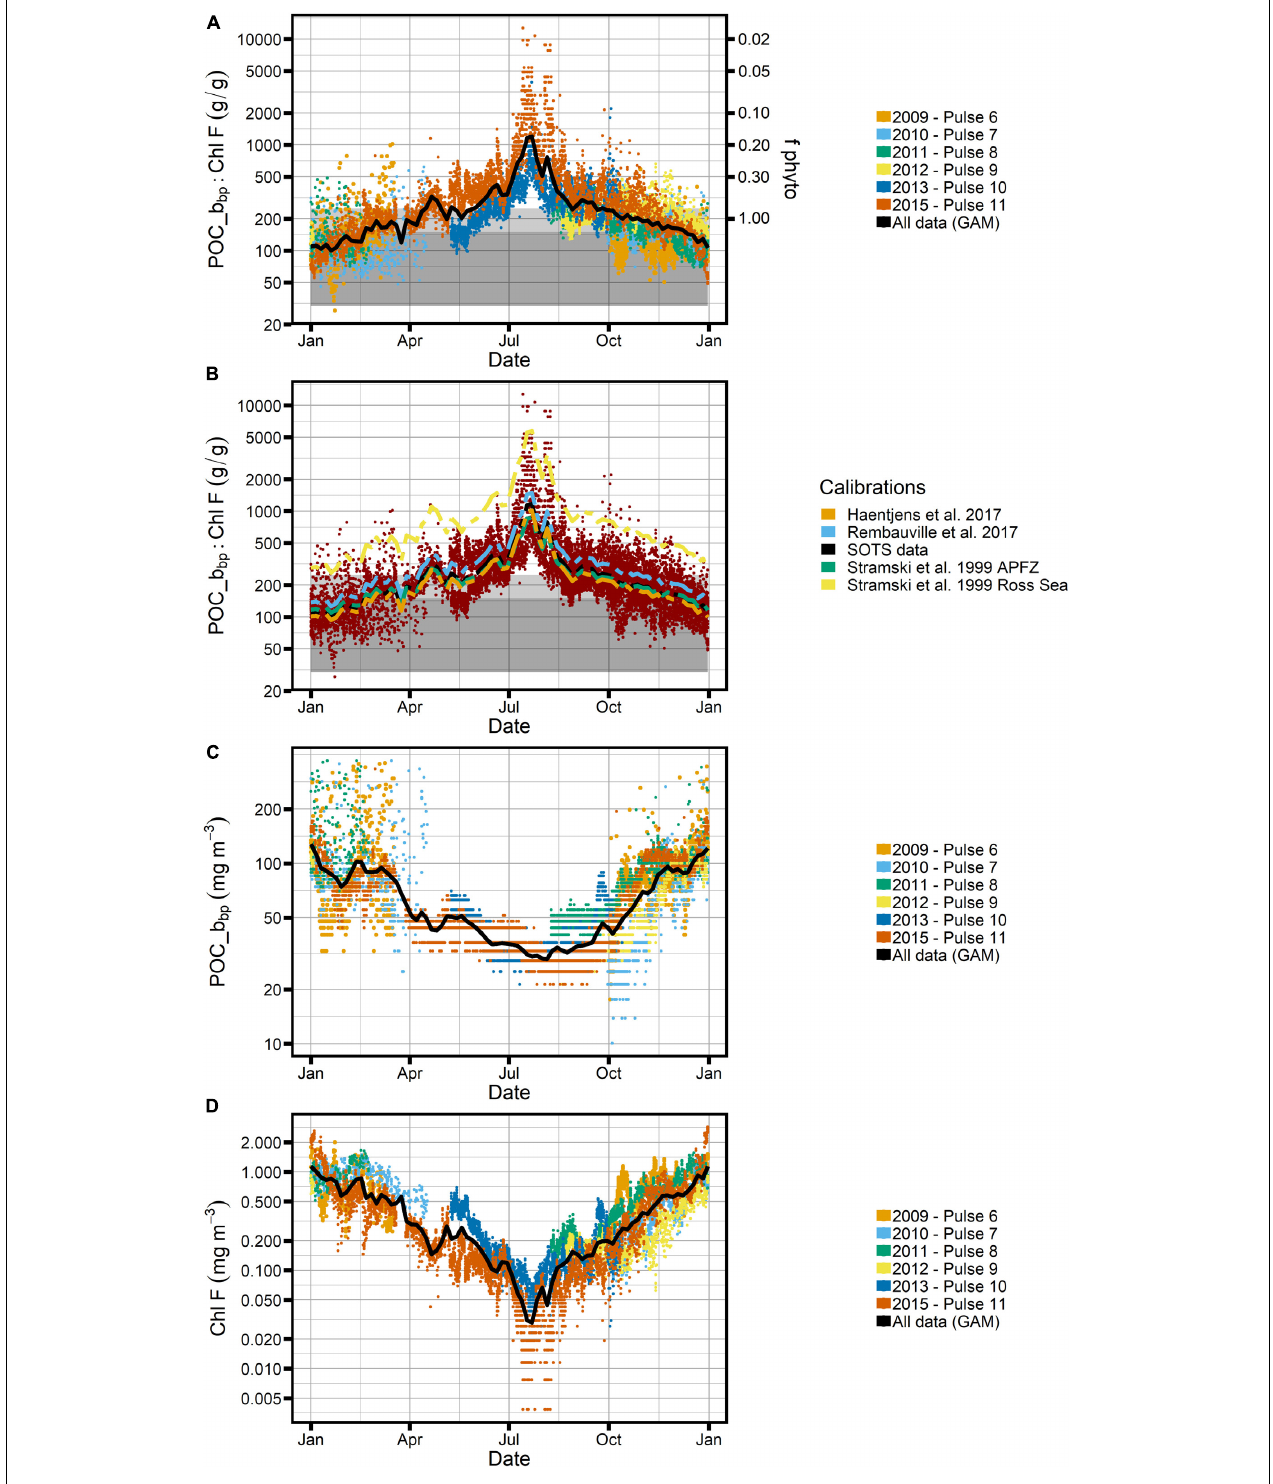
FIGURE 6 | Ratio of POC_b bp to Chl-F (SAZ-Sense calibration) over the seasonal cycle. (A) All data from Pulse moorings, colored by deployment and with gray bar representing POC:Chl values thought to represent phytoplankton. The black line represents all data smoothed using a generalized additive model (GAM). Right-hand axes indicated the fraction of phytoplankton carbon relative to all carbon (f phyto ) when a conservative POC:Chl ratio of 200 is assumed for phytoplankton. (B) Comparison of POC calibration created using SAZ-Sense data (black line) to calibrations using relationships from other studies (see Figure 4 ). (C) Seasonal cycle of POC_b bp and (D) seasonal cycle of Chl-F individually, with GAM in black. Note logarithmic scale for the y -axis in all panels.